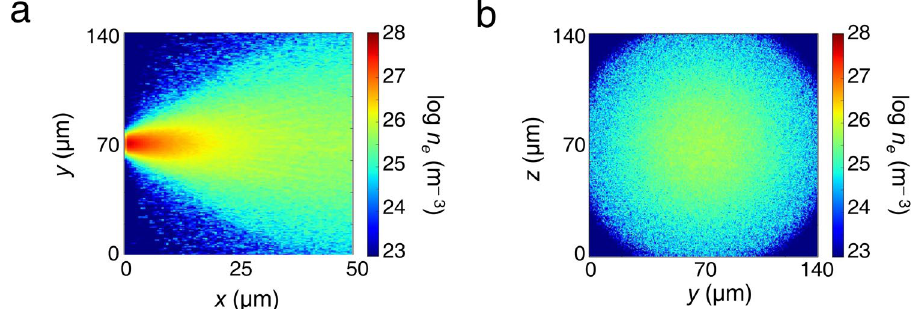
Figure 3. Results of the ZEPHYROS simulations at 0.7 ps, showing the ( a ) longitudinal and ( b ) transverse profiles of the electron density n e . These simulations corroborate the experimentally observed collimated hot electron transport pattern through the target at early